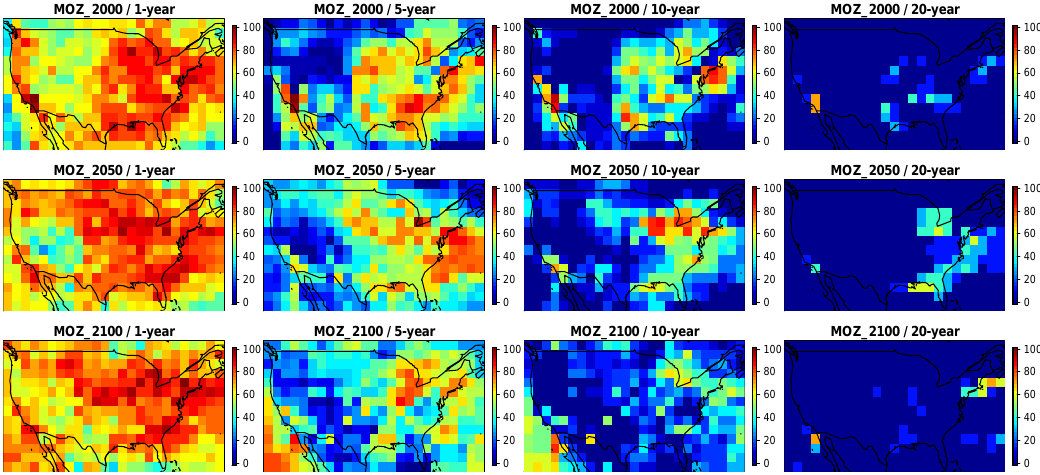
Figure 6. As in Fig. 5, but only the second row (1ppbv threshold), for present-day CAM-chem (MOZ_2000), future CAM-chem 2050 (MOZ_2050), and future CAM-chem 2100